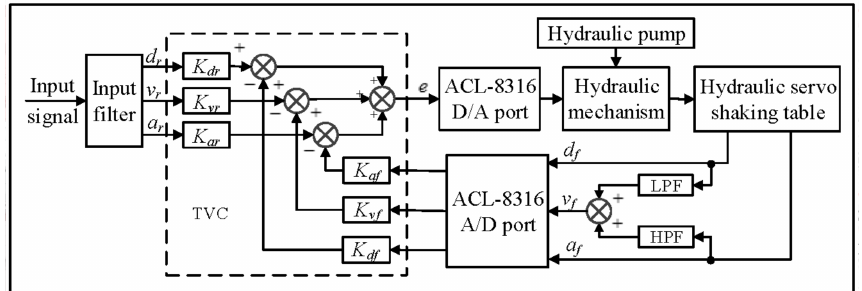
Figure 3. Control principal of the hydraulic servo shaking